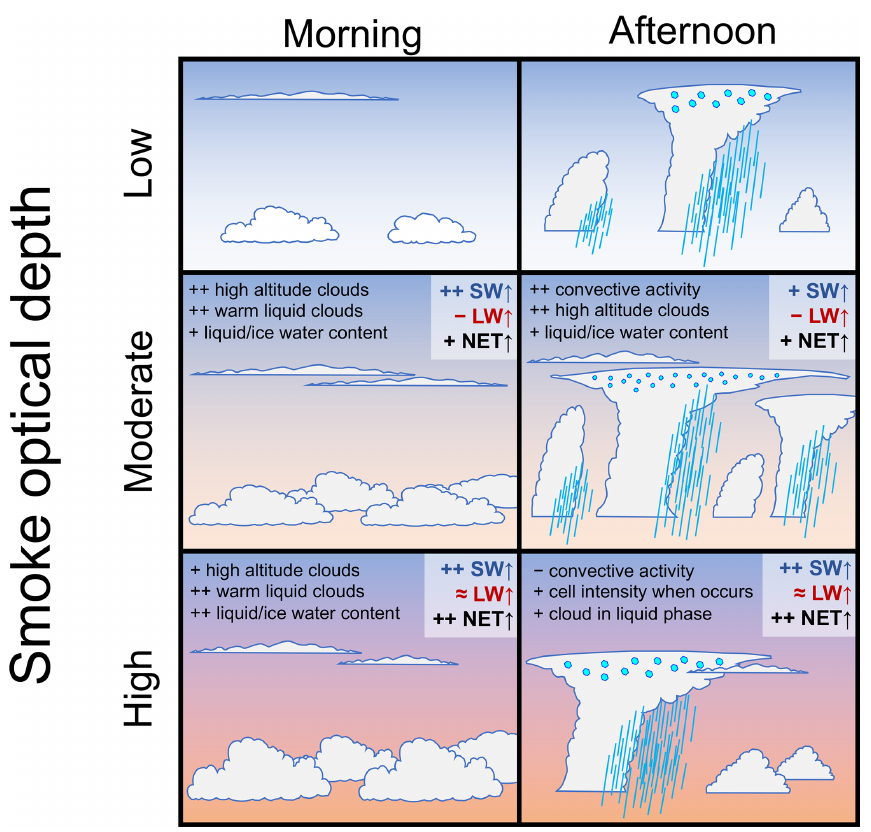
Figure 15. Summary of results from an 18-year time series of collocated MODIS, CERES, and AIRS observations on board TERRA (morning overpass) and AQUA (afternoon overpass) satellite platforms, combined with IMERG precipitation estimates, during the peak biomass burning month of September over the Amazon rainforest. Panels are shown for low (AOD < 0.1), moderate (AOD = 0.4), and high (AOD > 1.0) smoke optical depths. Annotations are included to highlight primary responses to the cloud field and TOA outgoing radiation fluxes as compared to the background low-AOD scene; symbols depict increases ( + ), substantial increases ( ++ ), decreases ( − ), and relatively little change ( ≈